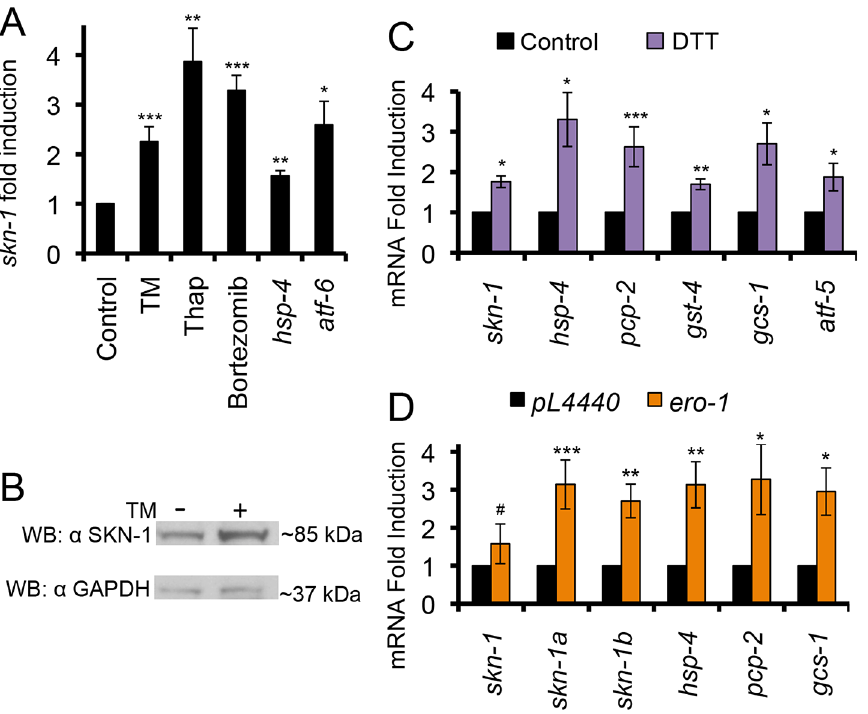
Figure 4. ER stress activates SKN-1 independently of oxidative stress. (A) Treatment with TM (16 hrs), thapsigargin (Thap, 2 hrs), or bortezomib (6 hrs) increased skn-1 mRNA levels, as determined by qRT-PCR. RNAi knockdown of hsp-4 or atf-6 also increased skn-1 mRNA levels. (B) Increased endogenous SKN-1 protein levels in response to TM-induced ER stress. SKN-1 was detected by Western blotting with the polyclonal antibody, with GAPDH serving as the loading control. (C) Induction of skn-1 expression and SKN-1-regulated UPR target genes by reductive ER stress (DTT treatment for 2 hrs), assayed by qRT-PCR. (D) Induction of the UPR, skn-1 expression, and SKN-1 target genes by ero-1 RNAi, assayed by qRT-PCR. Different primer sets were used to distinguish among mRNAs that correspond to different skn-1 isoforms. Error bars represent SEM, and * p # .05, ** p # .01, *** p # .001, relative to pL4440 Control calculated using student’s t-test. See also Figure S4 and Table S3. genes (Figure 5A). Knockdown of xbp-1 under control conditions increased background expression of some SKN-1 isoforms and target genes ( skn-1b , pcp-2 , gst-4 , hsp-4 ), possibly because ER stress was increased, but also interfered with ER stress-induced activation of several of these genes ( skn-1a , pcp-2 , gcs-1 , hsp-4 ) (Figure S5A). RNAi against ire-1 , which is essential for XBP-1s expression [5,6], also blocked TM-induced accumulation of SKN- 1, Pol II, or P-Ser2 at the gst-4 , pcp-2 , and atf-5 loci (Figures 5B–